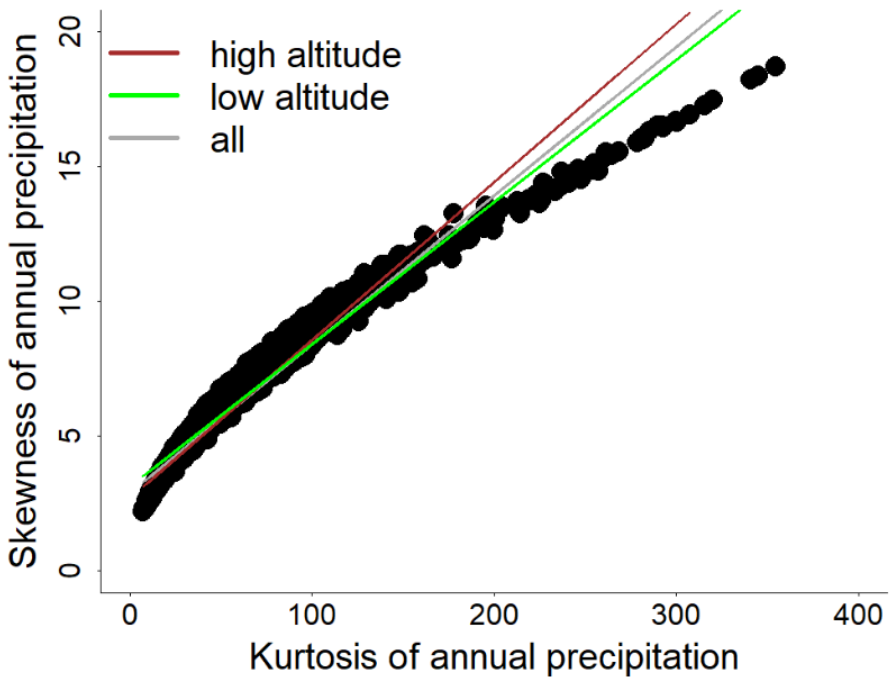
Figure 3. The relationship between the skewness and kurtosis of annual precipitation distributions based on recorded data from 78 meteorological stations on the QTP from 1960 to 2015. All three lines indicate results of linear regression. Different colors correspond to high-altitude stations (brown), all stations (grey), and low-altitude stations (green), respectively.